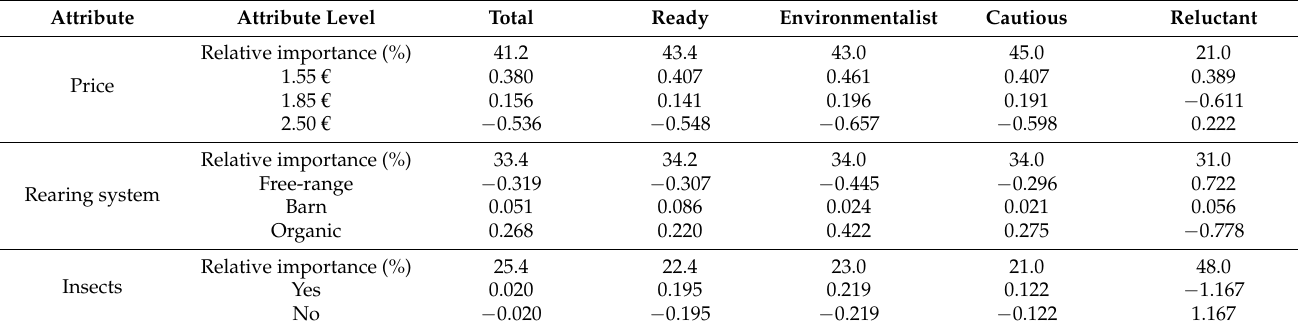
Table 8. Conjoint analysis: relative importance and utilities of total sample and by